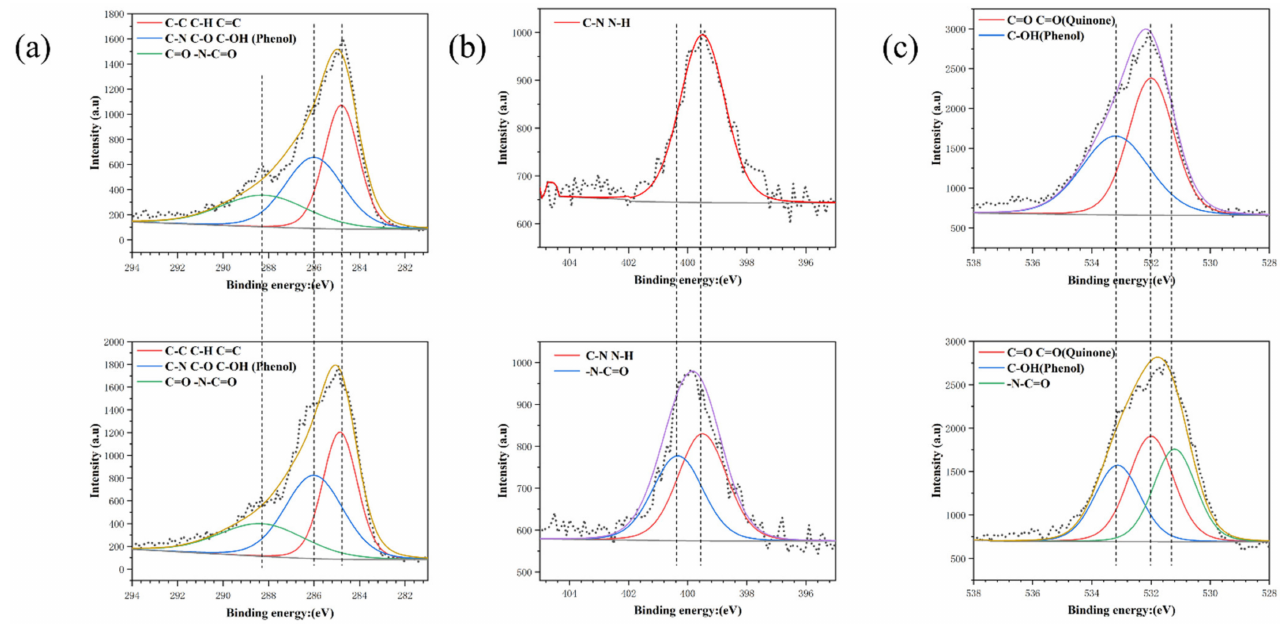
Figure 4. High resolution spectra of C1s ( a ) N1s ( b ) and O1s ( c ) of PDA and Fa-1